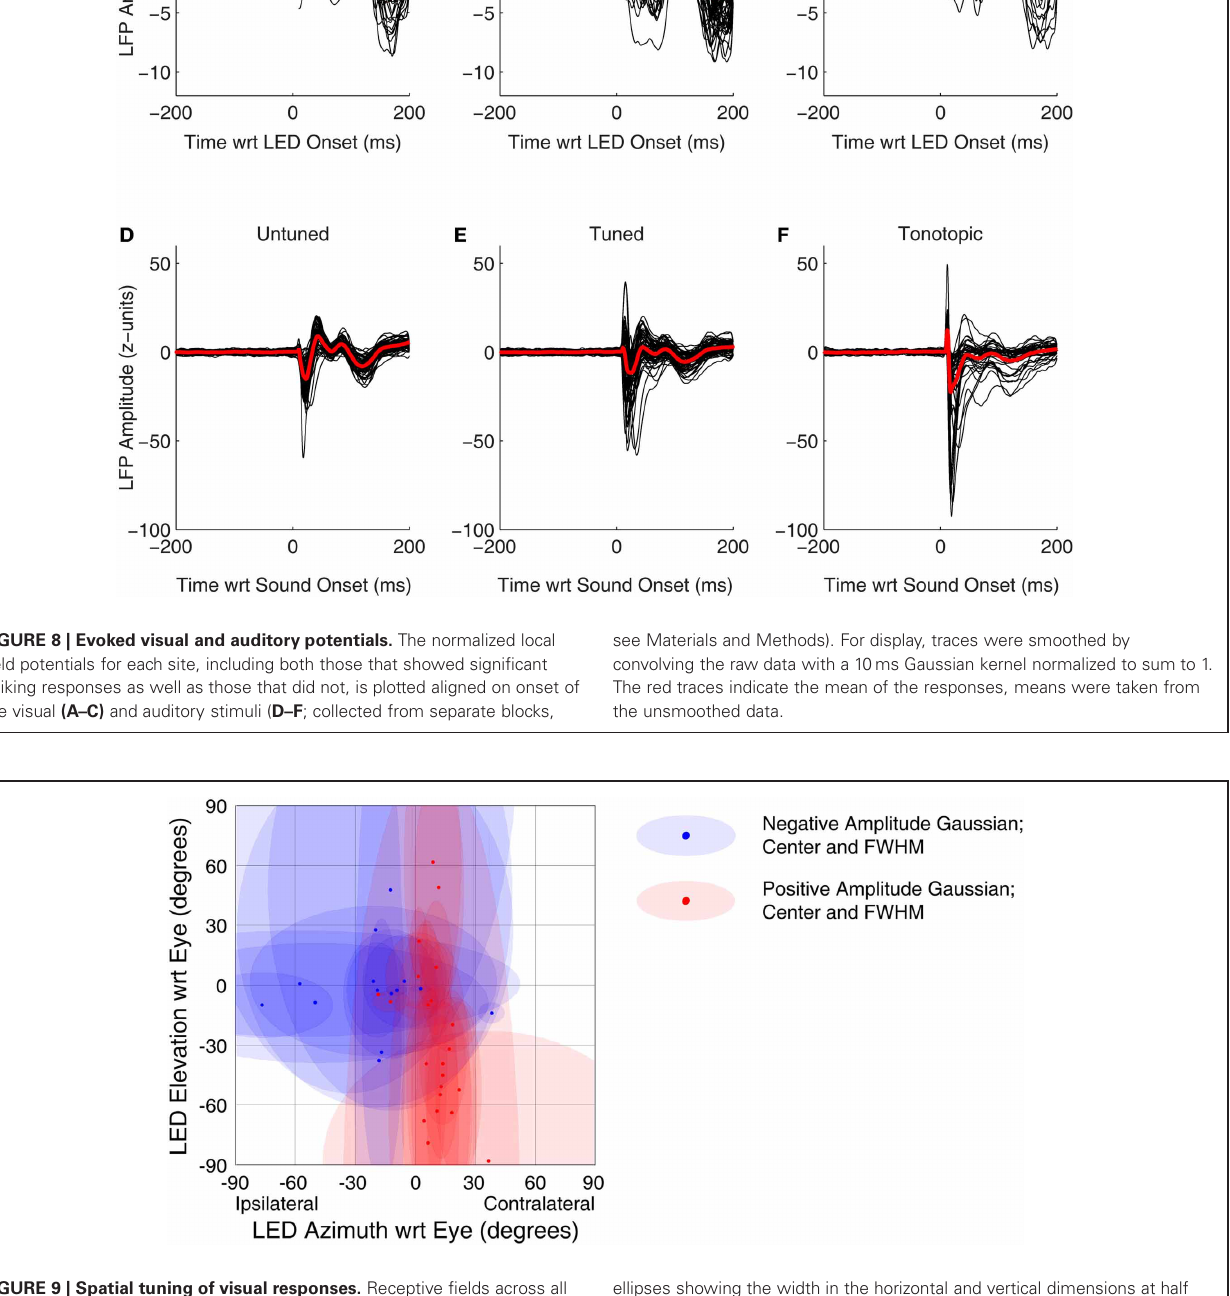
ellipses showing the width in the horizontal and vertical dimensions at half the maximum height of the Gaussian (with respect to its offset). Visually responsive recordings reliably showed increased firing rates to stimuli presented in the contralateral